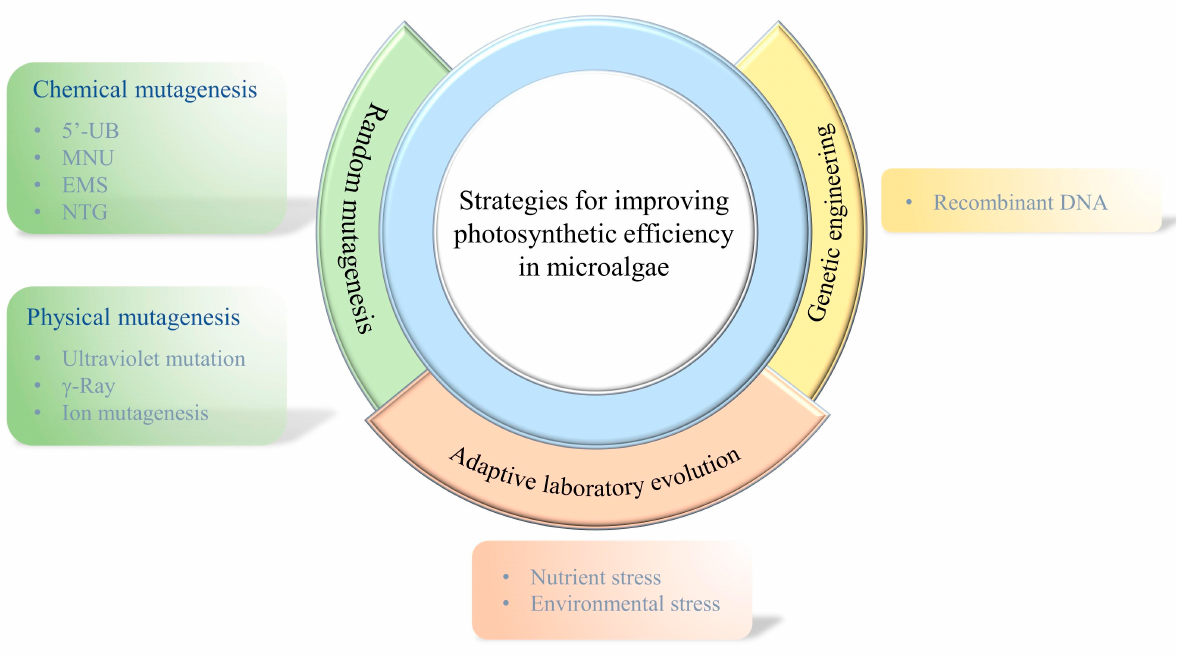
Figure 6. Strategies for improving photosynthetic efficiency in microalgae. Table 3. Application of strategies to improve the photosynthetic efficiency of microalgae.